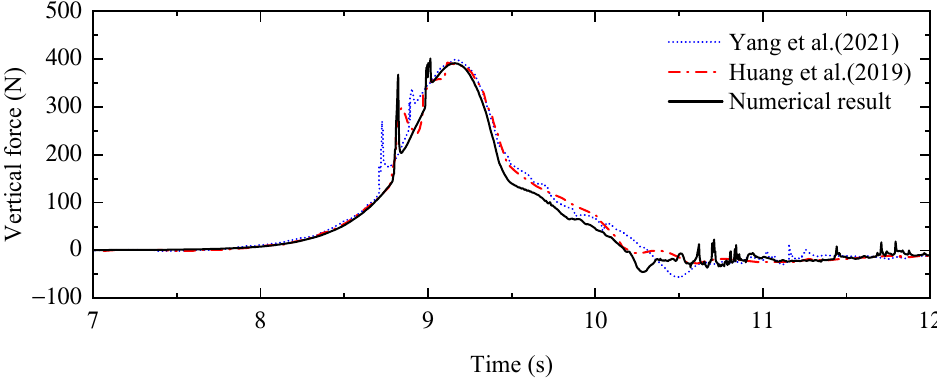
Figure 5. Vertical force comparison with experimental results and numerical simulation results. Figure 5. Comparison of the vertical force between the numerical result of current study, the experi- mental result of Huang et al. [45] and the numerical result of Yang et al. [50].